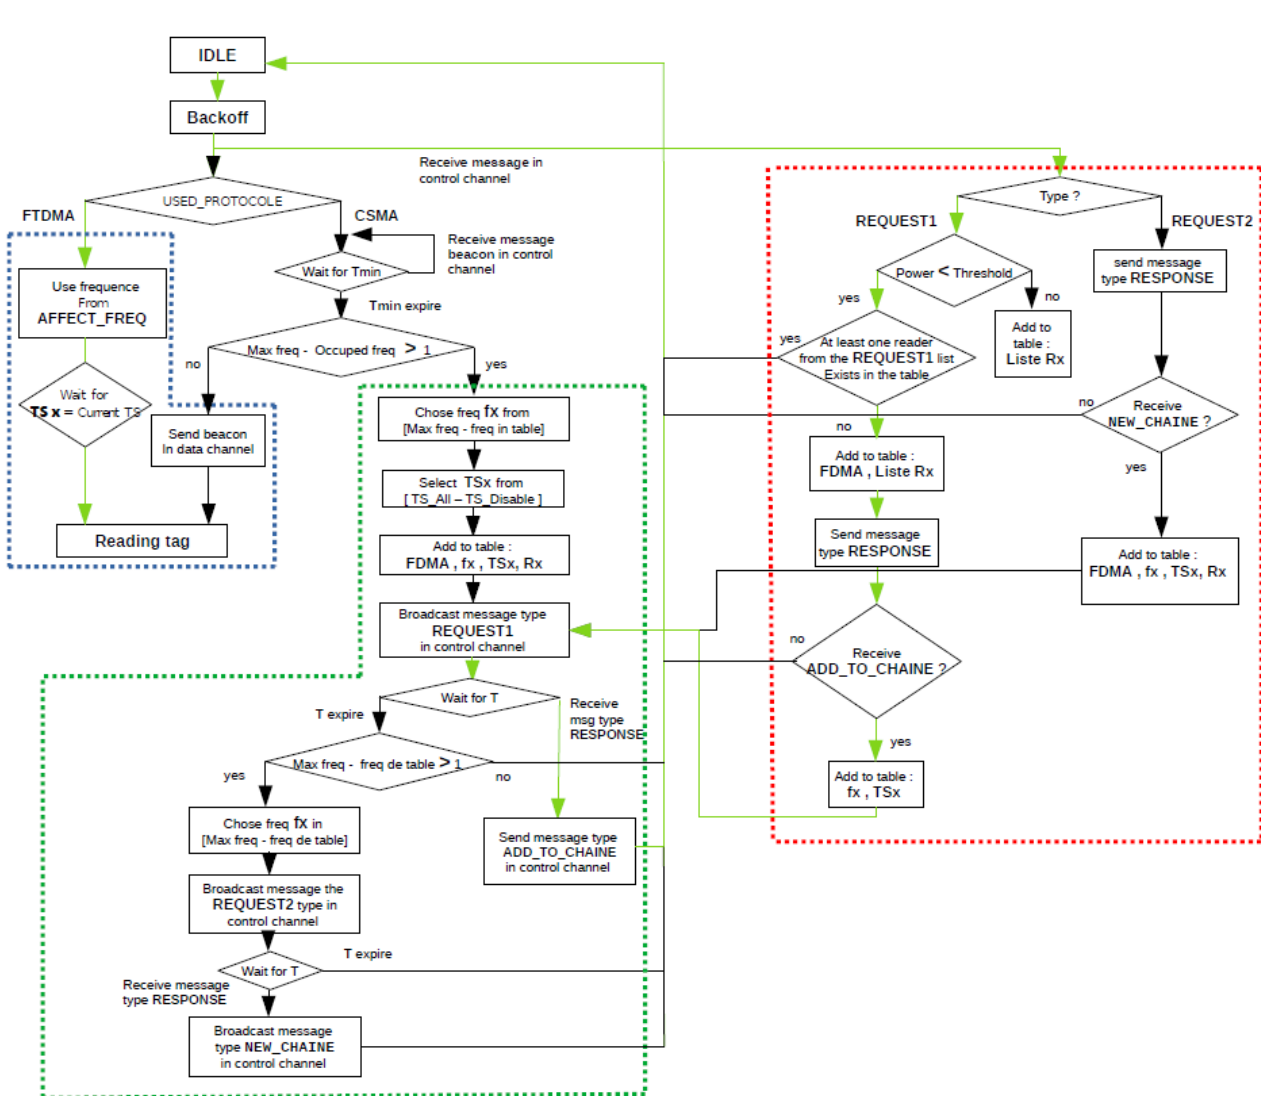
Figure A4. R10 Figure A4. R10 process.